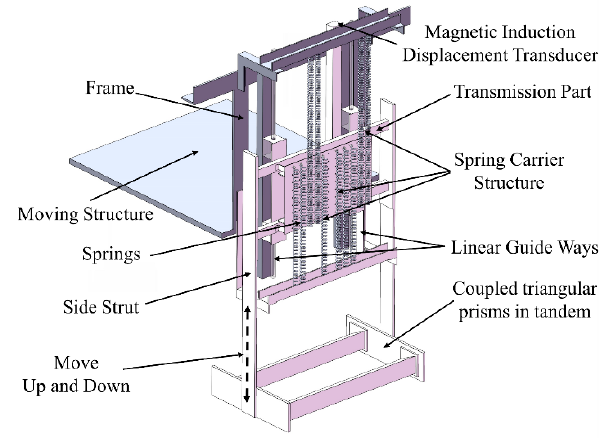
Figure 3. Oscillation system.